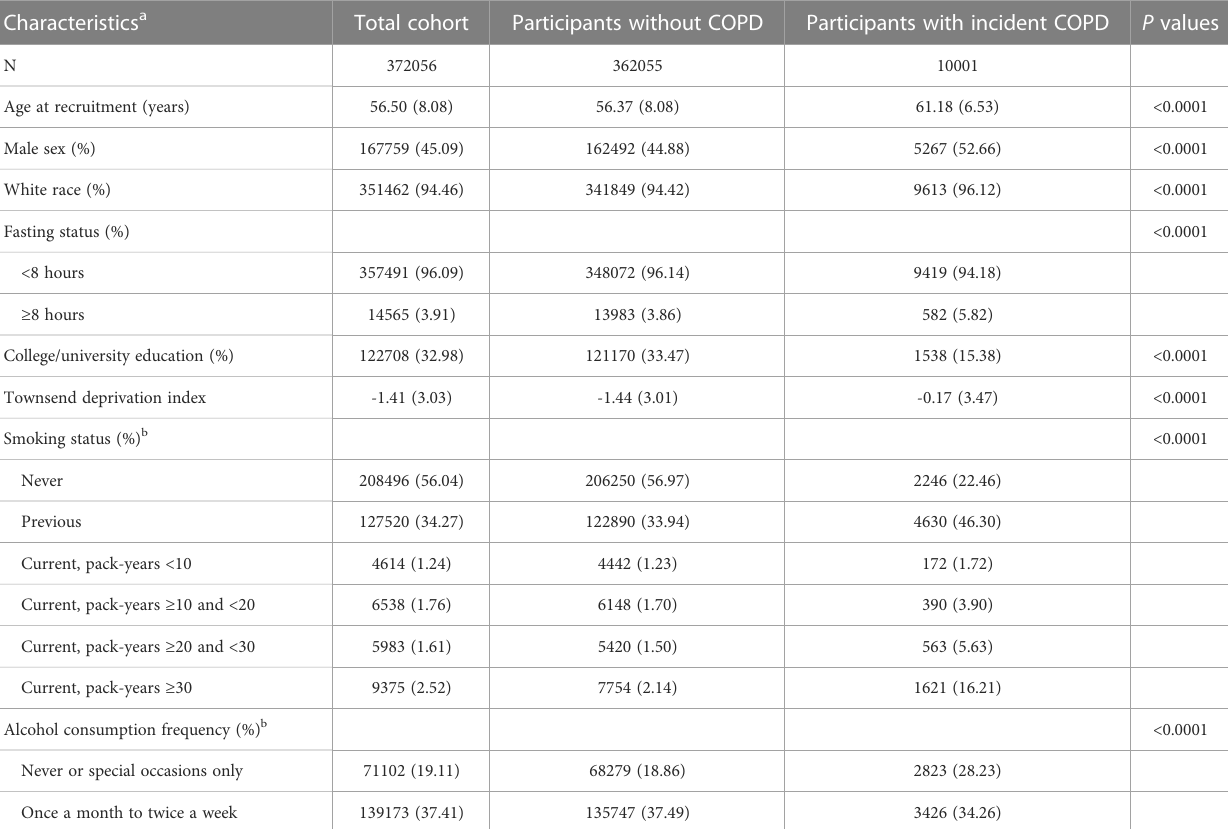
TABLE 1 Characteristics of study participants at